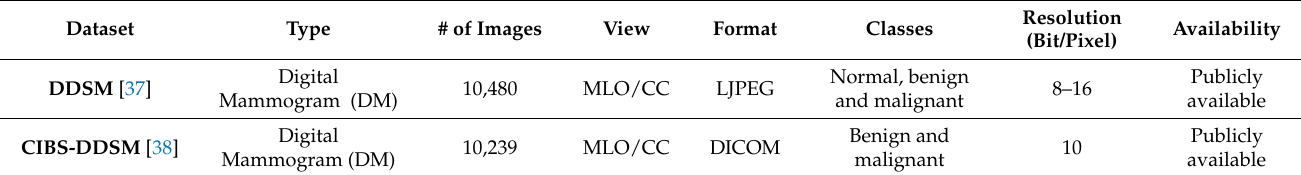
Table 3. Distribution of data.